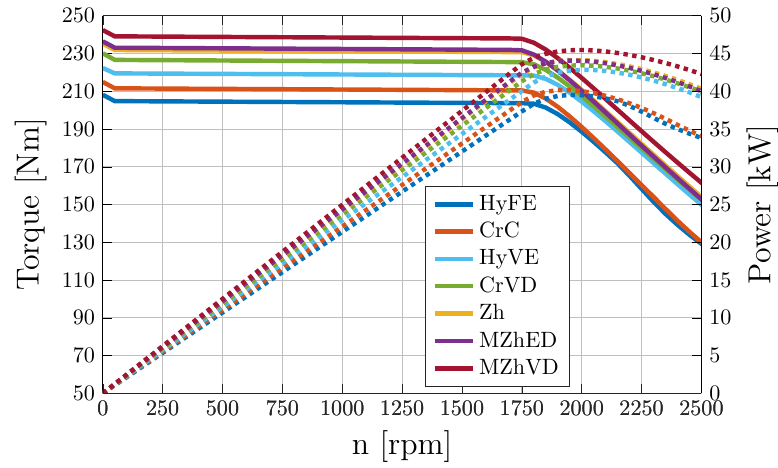
Figure 14. Performance curves of selected designs (Table 5).